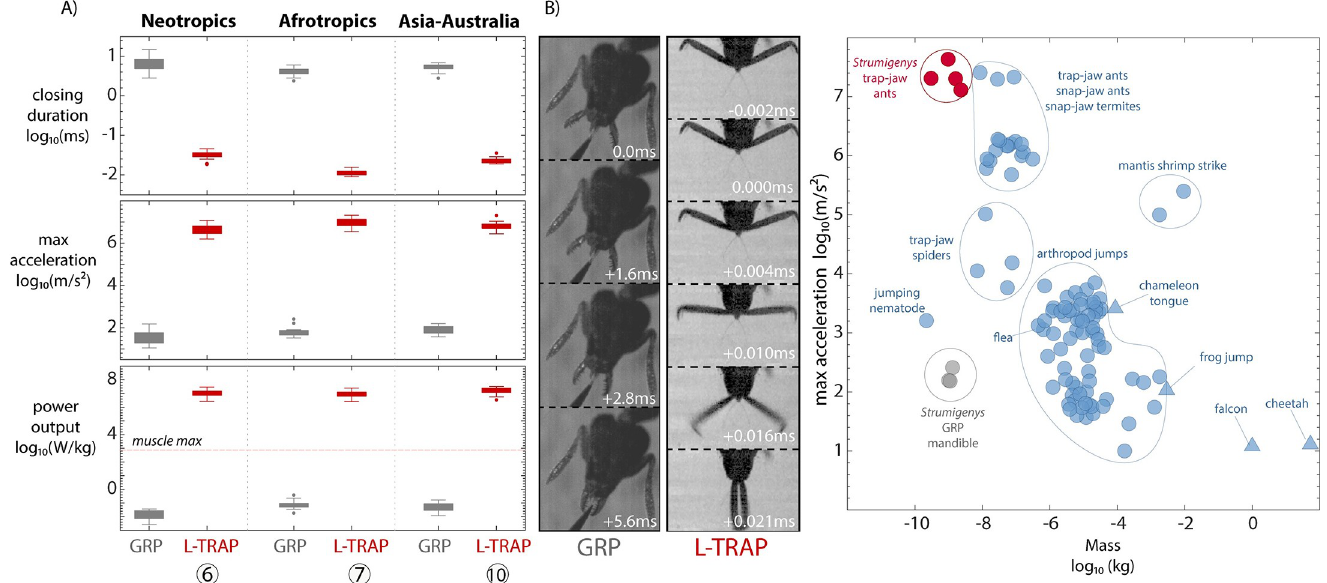
Fig 4. Parallel evolution of enhanced performance associated with the trap-mechanism. (A) Mandible closing duration, maximum linear acceleration, and power output measured with high-speed videography (boxes are middle 50% of data, whiskers are +/ − 2.7 s, points are outliers). The horizontal dashed line reflects the maximum power output known from biological muscle (730 W/kg) without an amplification mechanism. Each pair represents an independent evolution of power amplification and a related gripping lineage from the same clade. The measured species are, from left to right, S . depressiceps ( n = 18), S . elongata ( n = 17), S . simoni ( n = 14), S . rogeri ( n = 12), S . ohioensis ( n = 15), S . emmae ( n = 20). (B) Example photos from the performance measurement experiments (GRP: S . ohioensis , L-TRAP: S . elongata ). (C) Power-amplified Strumigenys mandibles exhibit the fastest acceleration of any resettable biological movement measured thus far, here L-TRAP species are compared with other invertebrates (circles) and vertebrates (triangles) compiled by Ilton and colleagues [10] and several other studies. The values for mass reflect the moving part or for jumping organisms, the whole body. The data underlying this Figure may be found at [https://doi.org/10.5061/dryad.d7wm37q0t] [41].